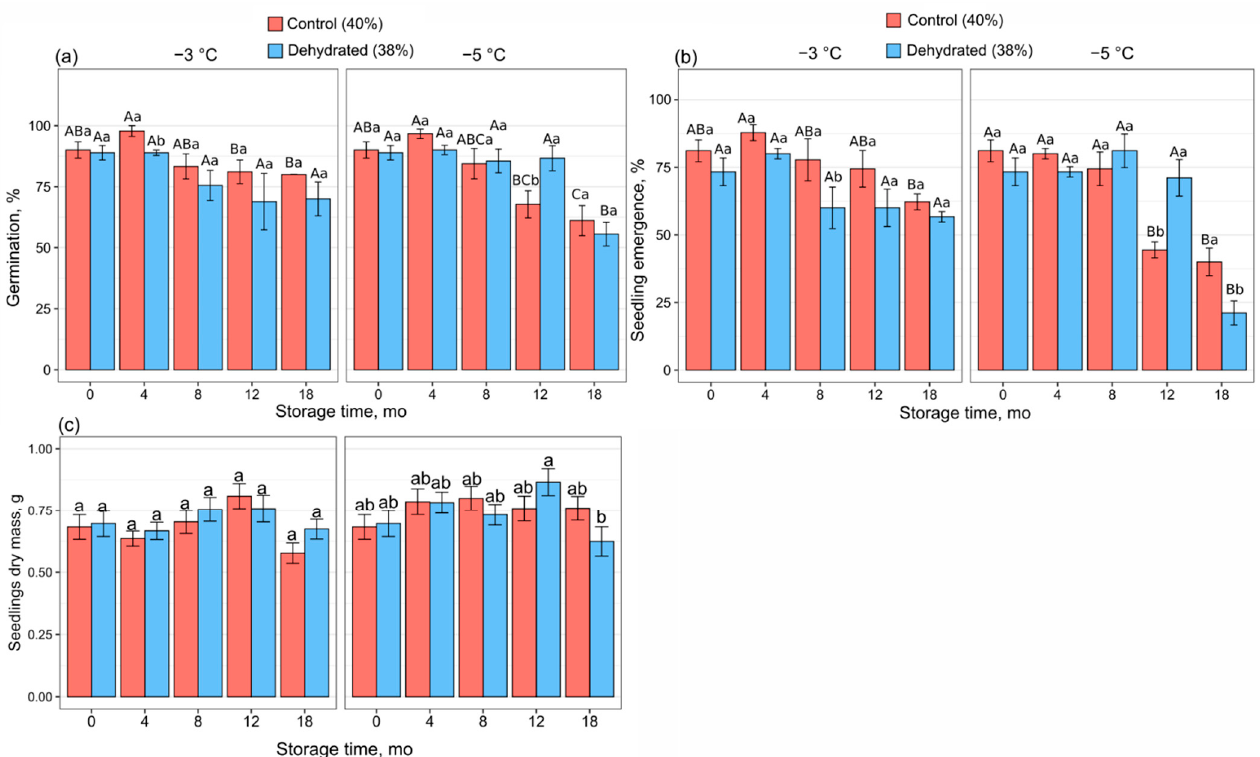
Figure 2. Germination capacity ( a ), seedling establishment ( b ) and seedlings dry mass ( c ) of peduncu- late oak acorns stored over 18 mo at − 3 ◦ C or − 5 ◦ C at 40 or 38% moisture content (MC). Data are the means of three biological replicates ± standard error. The same letters indicate groups that are not significantly different according to Tukey’s test. Capital letters indicate comparisons in time, and small letters refer to comparisons between MC levels at specific time points ( a , b ) or interaction effects ( c ). For detailed statistical results, please see Table S3.